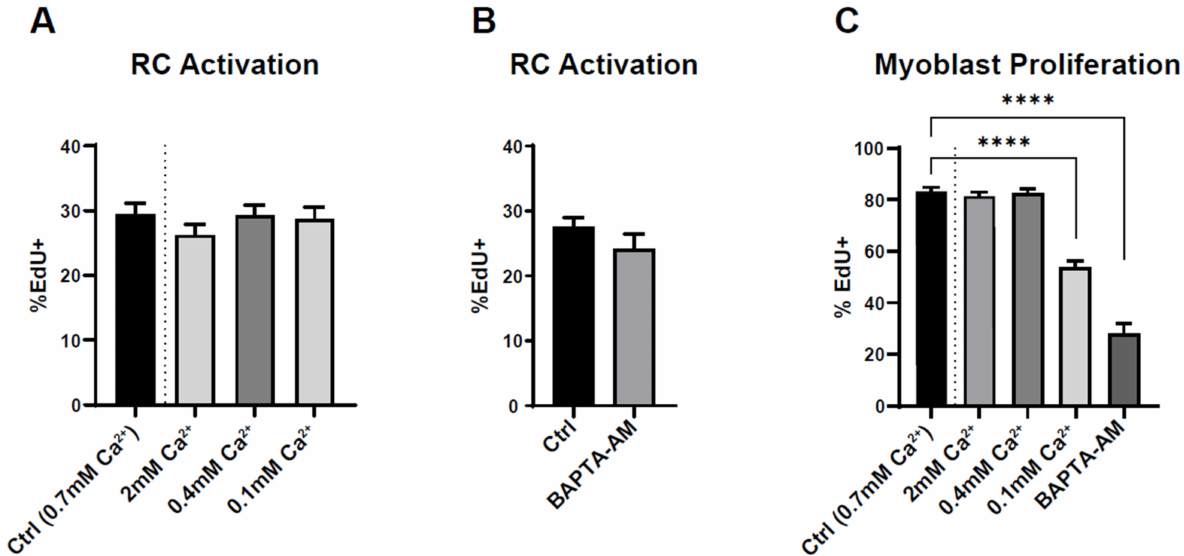
Figure 6. Effect of extracellular and intracellular Ca 2+ concentration on reserve cell activation and myoblast proliferation. ( A , B ) Myoblasts were differentiated for 48 h to obtain myotubes and RC, followed by stimulation with 15% serum for 24 h in the presence of EdU. The extracellular Ca 2+ concentration was modified 15 min before serum stimulation and kept for the next 24 h ( A ). Here, 10 µ M BAPTA-AM was added to the medium 15 min before serum stimulation ( B ). Statistics for ( A ) and ( C ) were calculated with a Kruskal–Wallis test and Dunn’s multiple comparisons test relative to control (**** p < 0.0001), and statistics for ( B ) were measured with a Mann–Whitney test. Bars are mean ± SEM. A total of 40–71 images were quantified from 4–5 independent experiments. Finally, we stimulated RC with endothelin-1 (a GPCR α q activator). Endothelin-1 receptor B (EDNRB) is expressed almost exclusively in the human reserve cells compared to myotubes and proliferating myoblasts (RNA seq, data not shown). This treatment